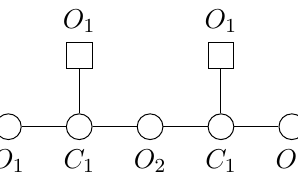
Figure 67. Quiver obtained from brane systems in the second row of table 6. Its Higgs branch is M H = D 4